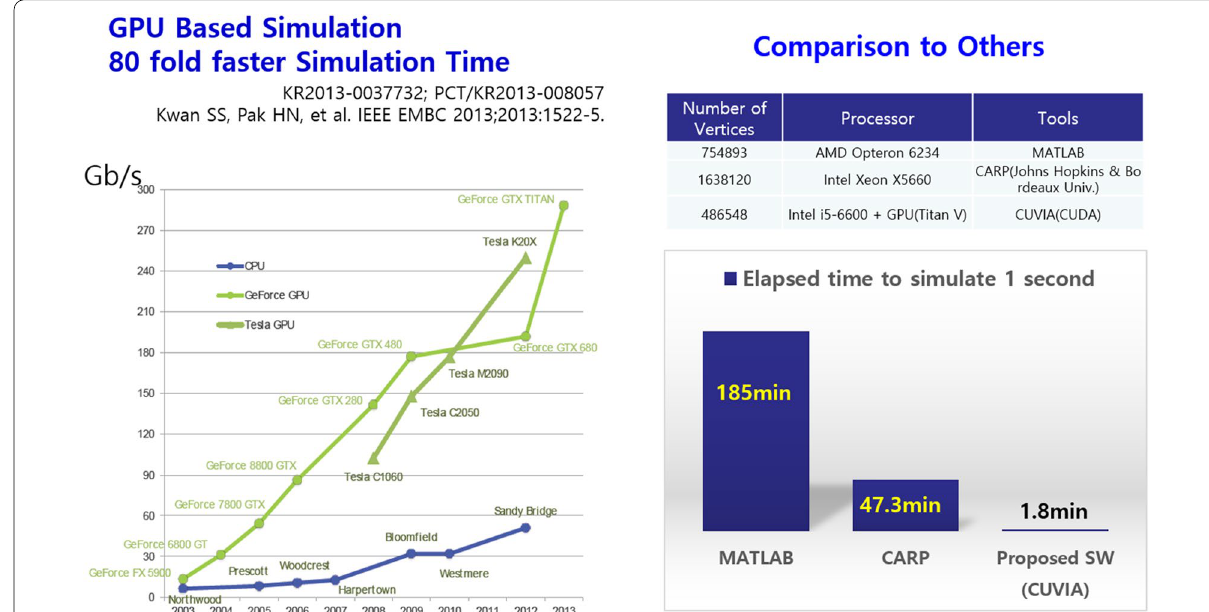
Fig. 2 Memory bandwidth growth rate of CPU and GPU, and performance comparison between software (SW) implemented with parallel computing and others SW. (Left) The finite difference method applied to AF simulation is particularly suitable for parallel computing due to its iterative nature and can solve partial differential equations at high speed through GPUs with high bandwidth and many cores compared to CPU. (Right) CUVIA SW, which is implemented based on CUDA‑based parallel architecture, shows significant performance compared to CARP (Johns Hopkins & Bordeaux Univ.) and MATLAB‑based SW designed with serial architecture